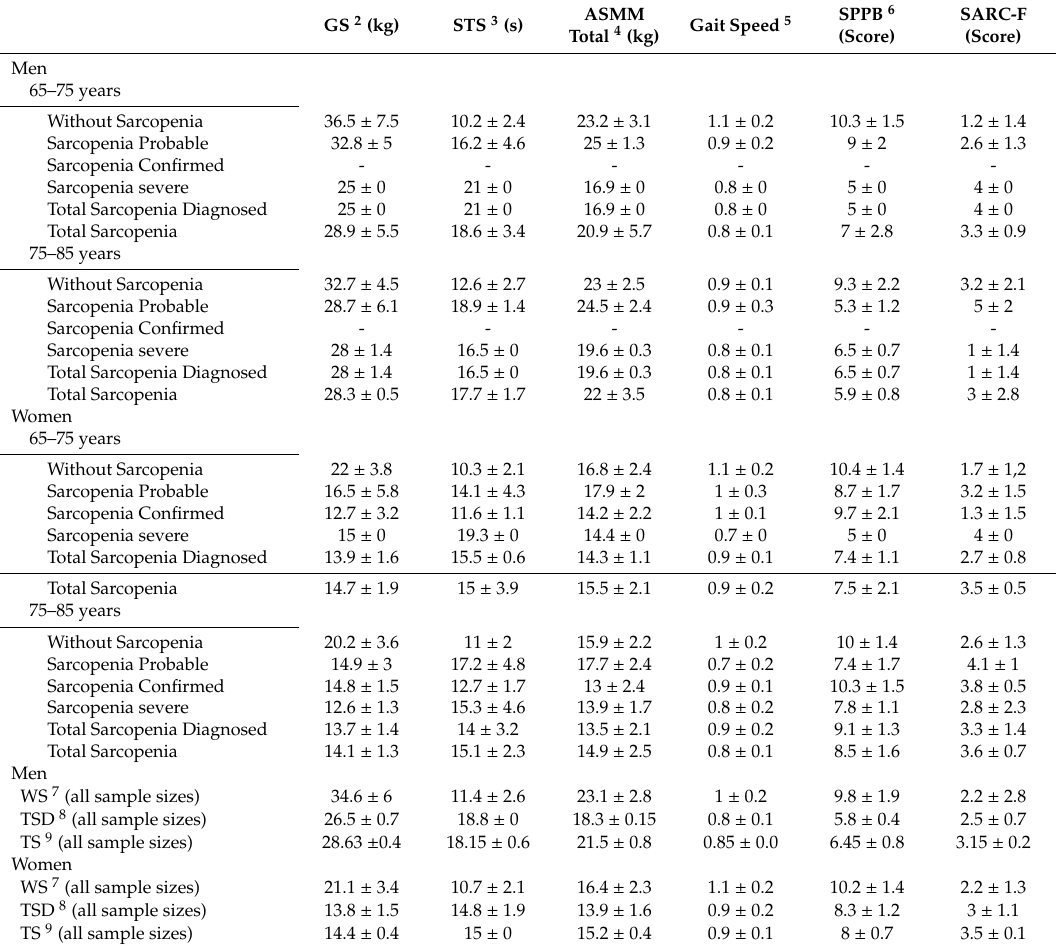
Table 2. Results of the di ff erent tests to assess sarcopenia in groups established by EWGSOP2 1 .